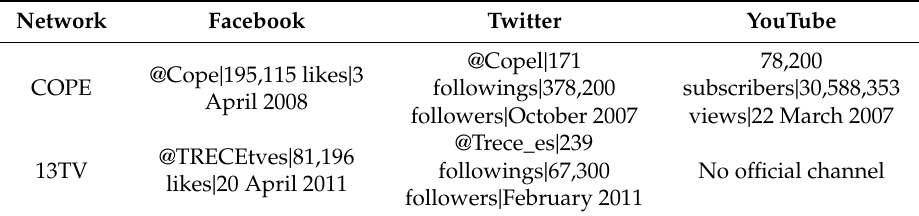
Table 1. CEE’s (Conferencia Episcopal Española) traditional networks on social media